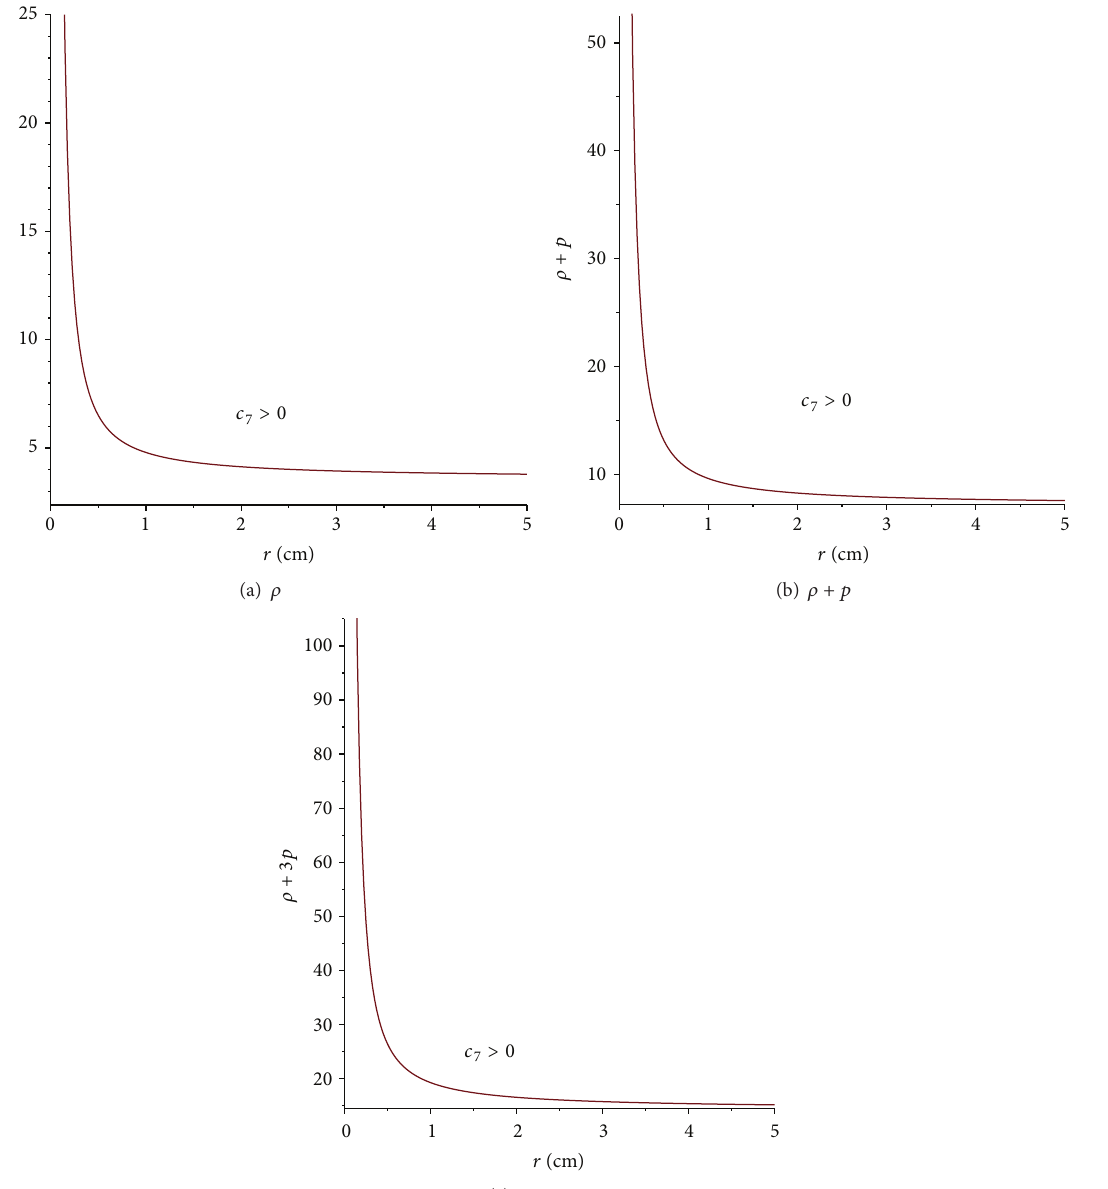
tetrad and have obtained anisotropic system that consists of four nonlinear differential equations. One of these deferential equations put a constraint on the form of 𝑓(𝑇) . This con- straint makes the form of 𝑓(𝑇) be 𝑓(𝑇) = 𝑇 . Using this form and the isotropic condition, that is, 𝑝 𝑟 = 𝑝 𝑡 , we get an isotropic